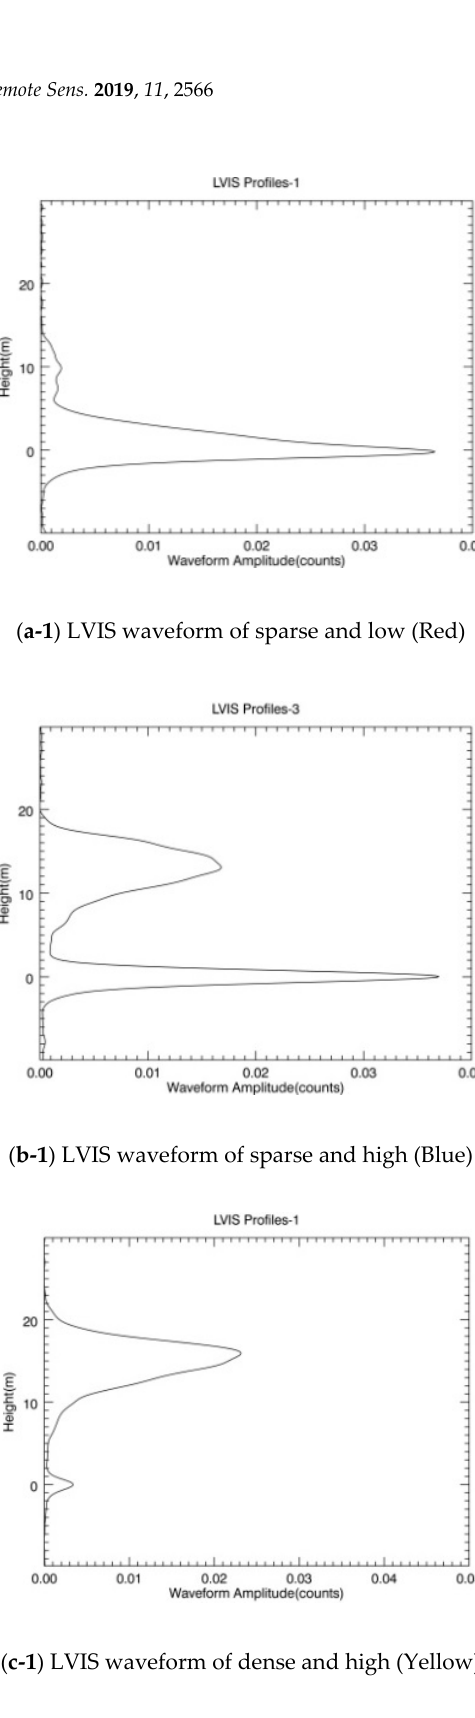
Figure 2. Laser vegetation imaging sensor ( LVIS) waveforms and high-resolution images for a typical forest stand in the Howland Forest: ( a-1 ) and ( a-2 ) represent the LVIS waveforms and high resolution images of the sparse and low forest stands in Figure 1; ( b-1 ) and ( b-2 ) represent LVIS waveforms and high resolution images of the sparse and high forest stands in Figure 1; ( c-1 ) and ( c-2 ) represent the LVIS waveforms and high resolution images of the dense and high forest stands in Figure 1.